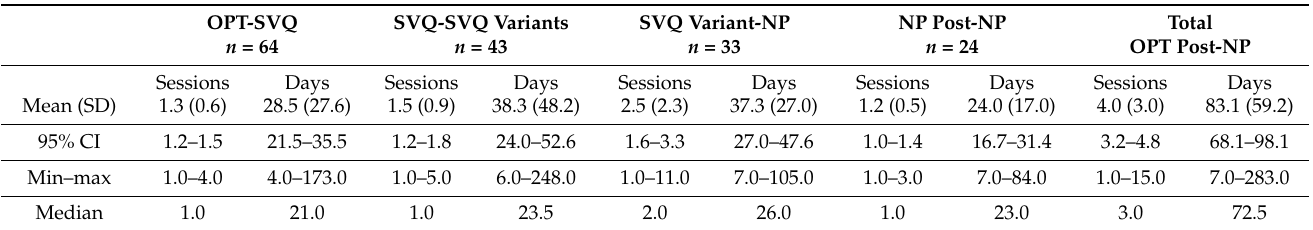
Table 2. Number of sessions and days between each technique and process of the Sob Voice Therapy. Abbreviations: SD, standard deviation, and CI, confidence